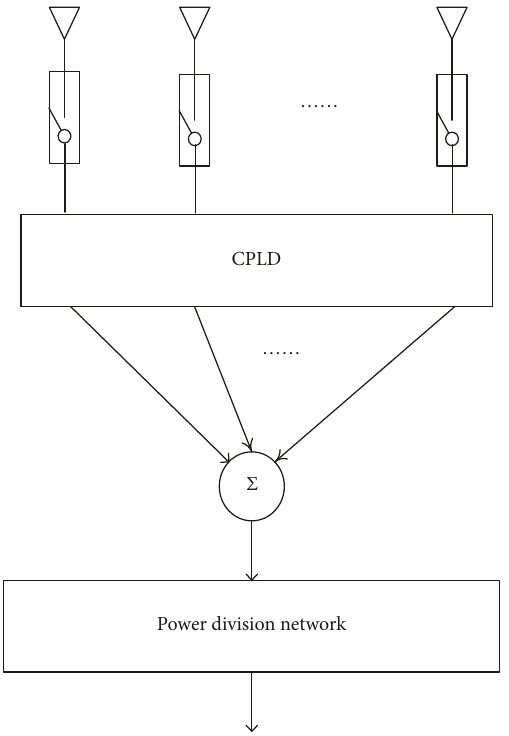
Figure 1: Basic structure of time-modulated antenna